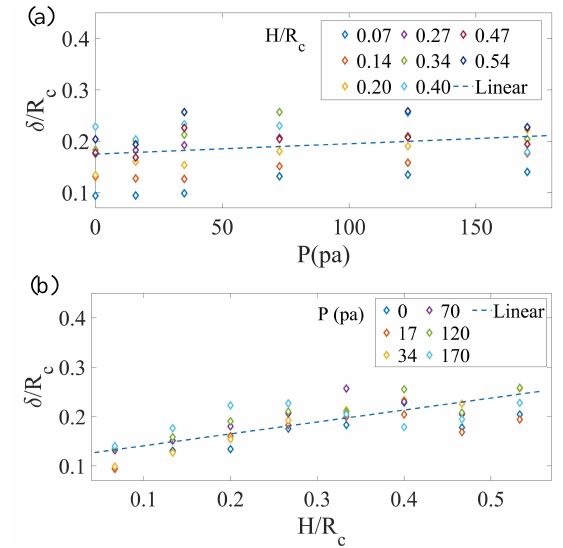
Figure 5. Width of the shear band, δ/ R c , as a function of (a) P for increasing values of the filling height H / R c from 0 . 07 to 0 . 54 (the dashed lines shows the linear fit to the average behavior of δ/ R c with increasing P ) and (b) H / R c for increasing values of the external pressure P from 0 to 170 pa (the dashed lines shows the linear fit to the average behavior of R s / R c with increasing H